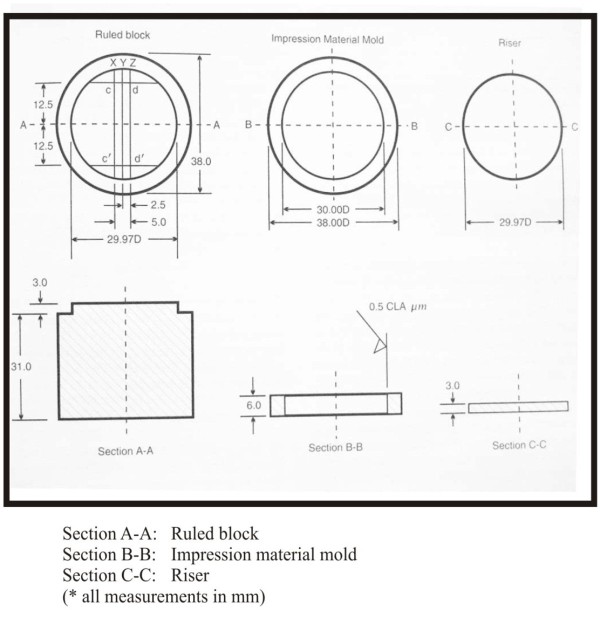
Schematic diagram of blockreproduction.